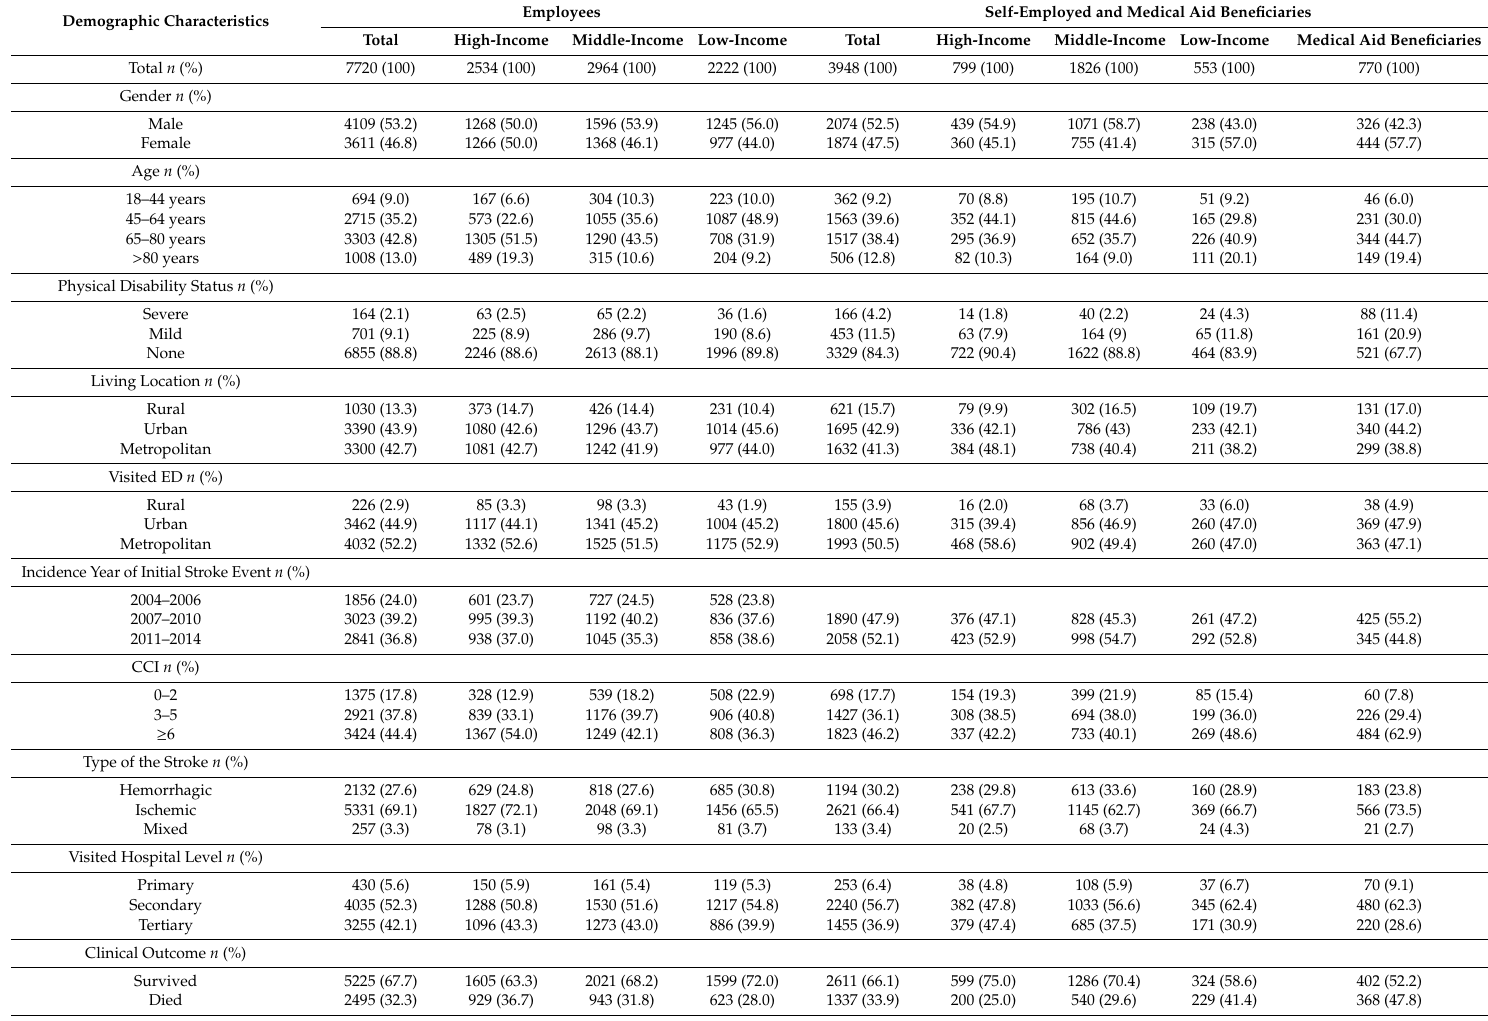
Table 1. Demographics of the Study